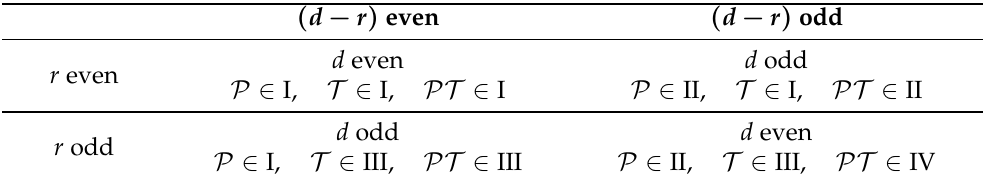
Table 2. Action of space reflections P and simple time reflections T for different dimensions and signatures of the generalized Lorentz group O ( r , d − r , R )